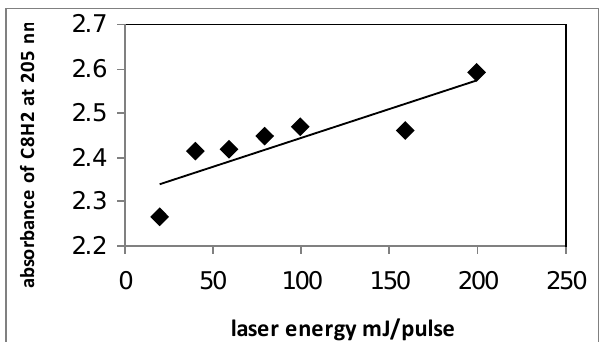
Fig.8: The effects of laser energy on the peak intensities of polyynes (C